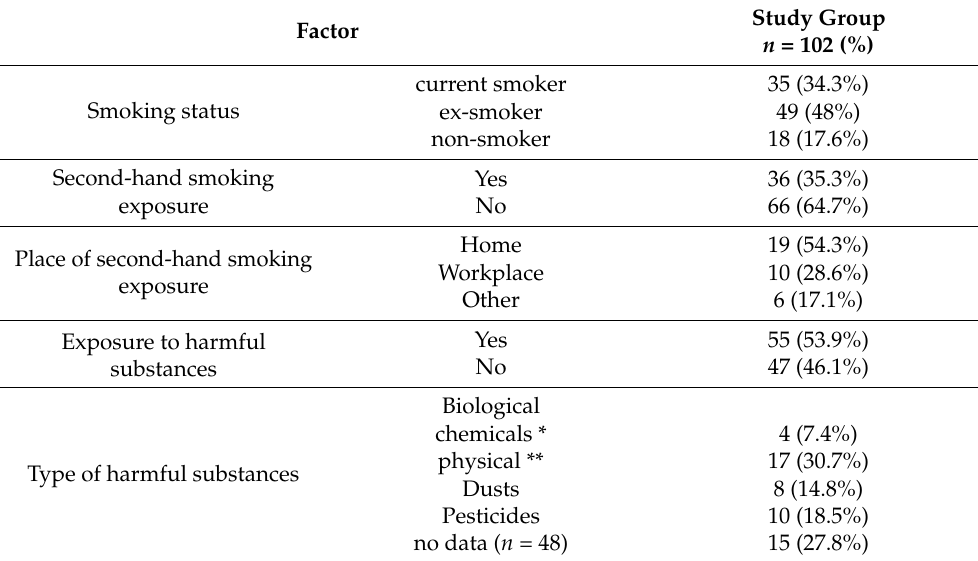
Table 2. Smoking status and occupational exposure to harmful substances in patients of the exam- ined